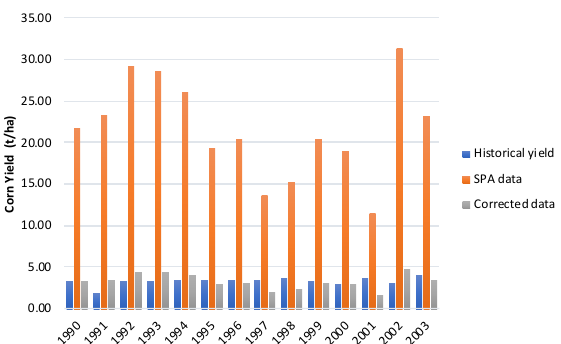
Figure 4. Historical, Projected Present time data, and Corrected Present time maize yield in the 1990–2003